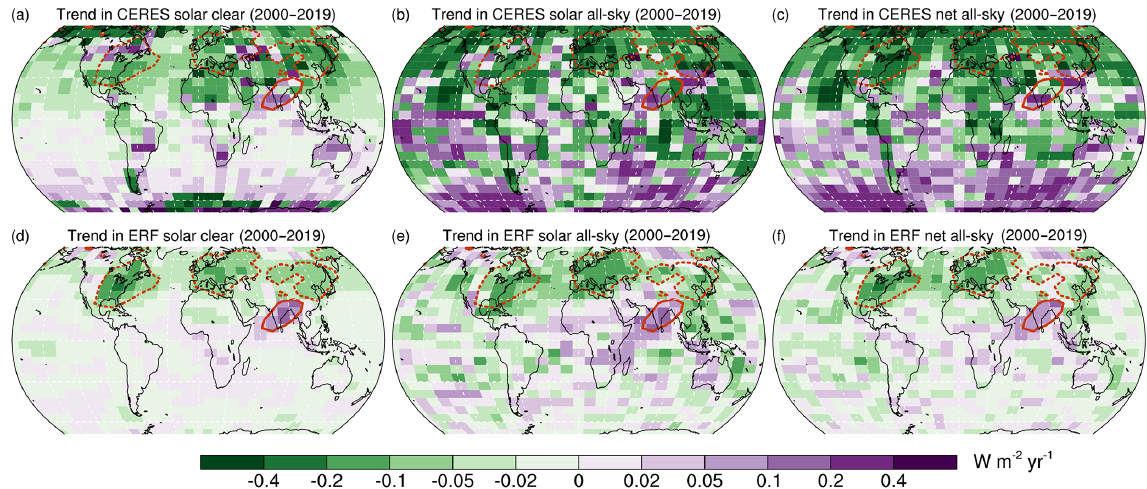
Figure 4. Linear trends (2000–2019) in (a) net broadband solar flux for clear-sky situations as retrieved from the Clouds and the Earth’s Radiant Energy System (CERES) Energy Balanced and Filled (EBAF) product (Loeb et al., 2018a) from Terra, averaged for years after 2002 with retrievals from Aqua as well. Panels (b) and (c) are the same as (a) , but for all-sky solar radiation fluxes and all-sky solar plus terrestrial net fluxes, respectively; (d–f) trends in effective radiative forcings (ERFs) due to aerosols as computed from the dedicated RFMIP (Pincus et al., 2016)/AerChemMIP (Collins et al., 2017), for which output was available from the CanESM5 (Swart et al., 2019), GISS-E2-1-G (Kelley et al., 2020), HadGEM3-GC31-LL (Andrews et al., 2019), IPSL-CM6A-LR (Boucher et al., 2020), MIROC6 (Hajima et al., 2020), NOAA-GFDL (Held et al., 2019), and NorESM2-LM (Seland et al., 2020); the ensemble average is shown for (d) clear-sky solar, (e) all-sky solar, and (f) all-sky net (solar plus terrestrial) spectra. Signs are inverted for consistency with the CERES results (negative trends in ERFaer mean decreases in absolute magnitude). Isolines enclose regions with trends in clear-sky solar ERF (d) larger than 0.05Wm − 2 yr − 1 in absolute terms. The average values in these regions are listed in Table 1 and discussed in Sect. 7. Net fluxes, defined as positive if downward, are plotted, consistently in the simulations and the satellite